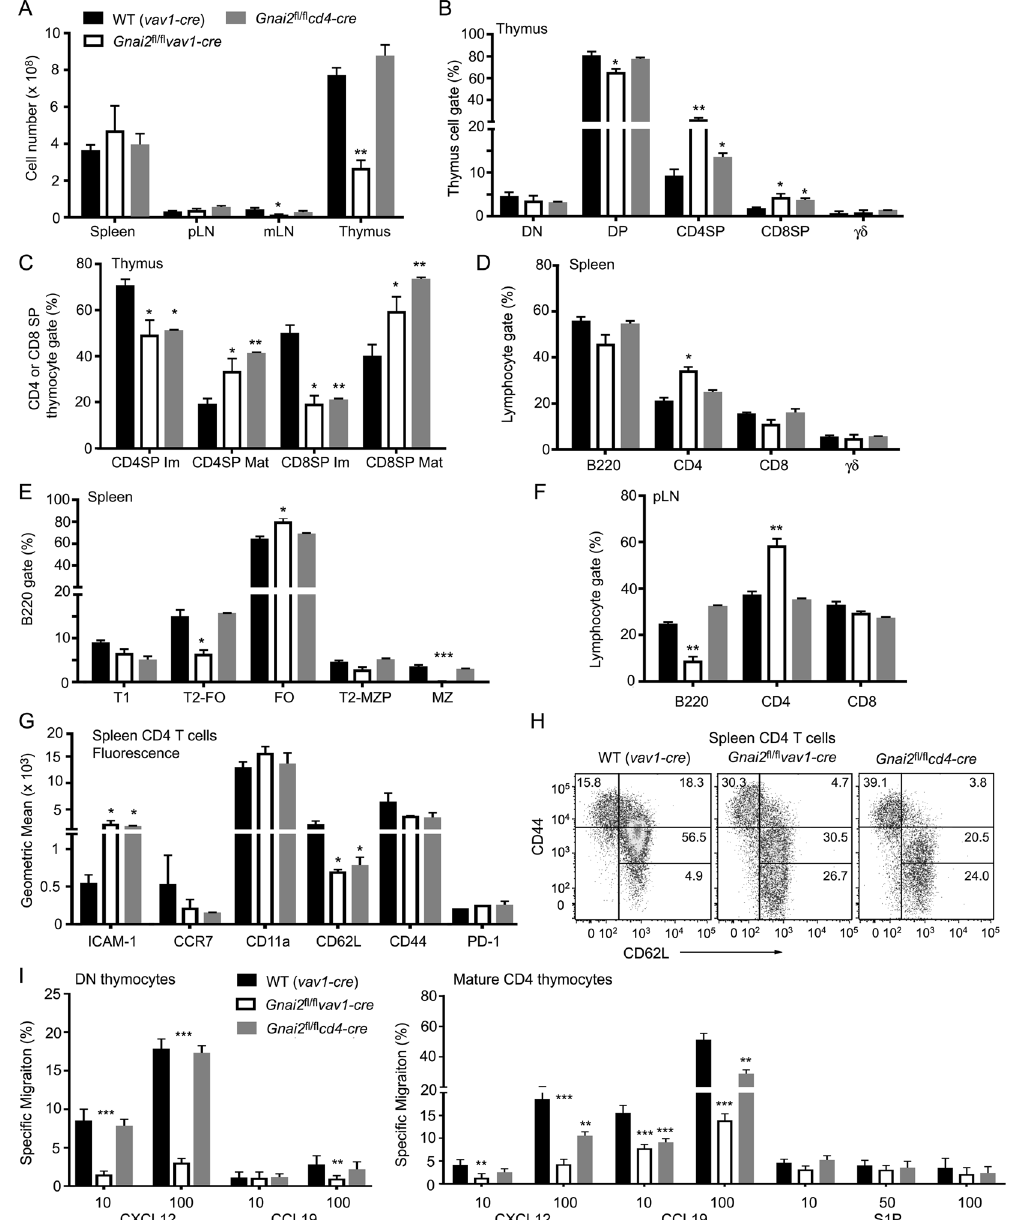
Figure 2. Comparison of deleting Gnai2 in hematopoietic progenitors versus DP thymocytes. ( A ) Lymphoid organ cell numbers from the indicated mice. ( B ) Flow cytometry results gating on thymocytes to determine the % of DN, DP, SP, and γδ thymocytes. ( C ) Flow cytometry results gating on SP thymocytes and examining CD62L versus CD69 expression. ( D ) Flow cytometry results examining the lymphocyte gate from splenocytes purified from the indicated mice to determine the percentage of B220, CD4, CD8, and γδ cells. ( E ) Flow cytometry results examining B cell development in the spleens of the indicated mice based on the expression of B220, CD21, and CD23. ( F ) Flow cytometry results examining the % of B220, CD4, and CD8 cells in peripheral lymph nodes from the indicated mice. ( G ) Flow cytometry results examining the expression of the indicated marked on splenic CD4 T cells from WT, Gnai2 fl/fl vav1-cre , and Gnai2 fl / fl cd4-cre mice. Results are shown as geometric mean from 4 mice of each genotype. ( H ) Enumeration of naïve and memory CD4 T cells from the spleen of the indicated mice based on expression of CD44 and CD62L. Representative flow cytometry pattern are shown. ( I ) CXCL12, CCL19, and S1P migration assays using DN and mature SP CD4 thymocytes prepared from the indicated mice. Percentages of cells responding to the different chemoattractants are shown. * p < 0.05, ** p < 0.005 and *** p < 0.0005 (Student’s t -test). Experiments were performed a minimum of 3